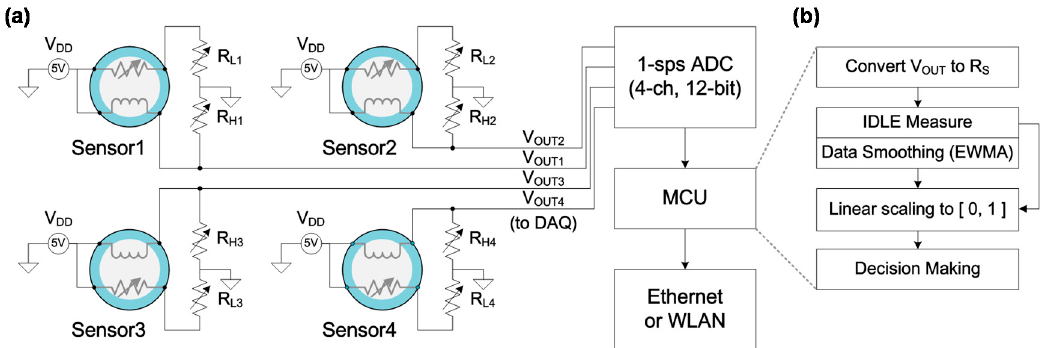
Figure 4. ( a ) Interface circuitry and block diagram of the fire detection module with metal-oxide gas sensors; ( b ) flow chart of the decision process.